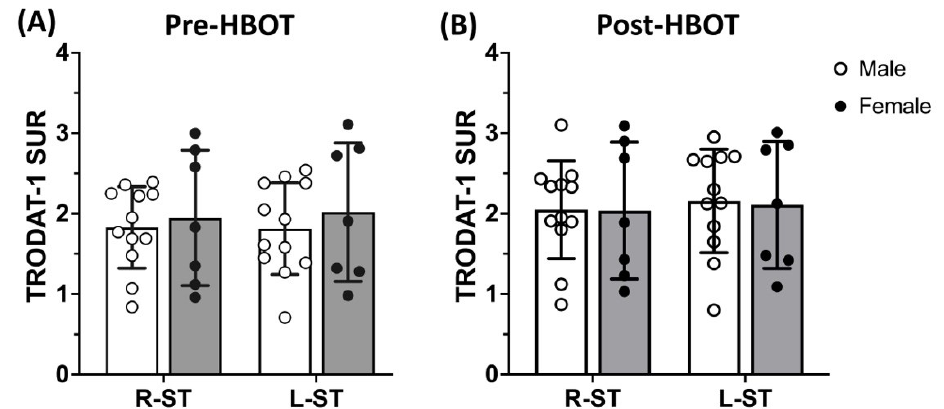
Figure 5. Dopamine transporter (DAT) availability (SURs) in the right and left striata in male and female subjects. There was no difference between male and female subjects at ( A ) baseline (pre-HBOT) or ( B ) 3-month follow up (post-HBOT). Data are mean ± SD. RS, right striatum; LS, left striatum.